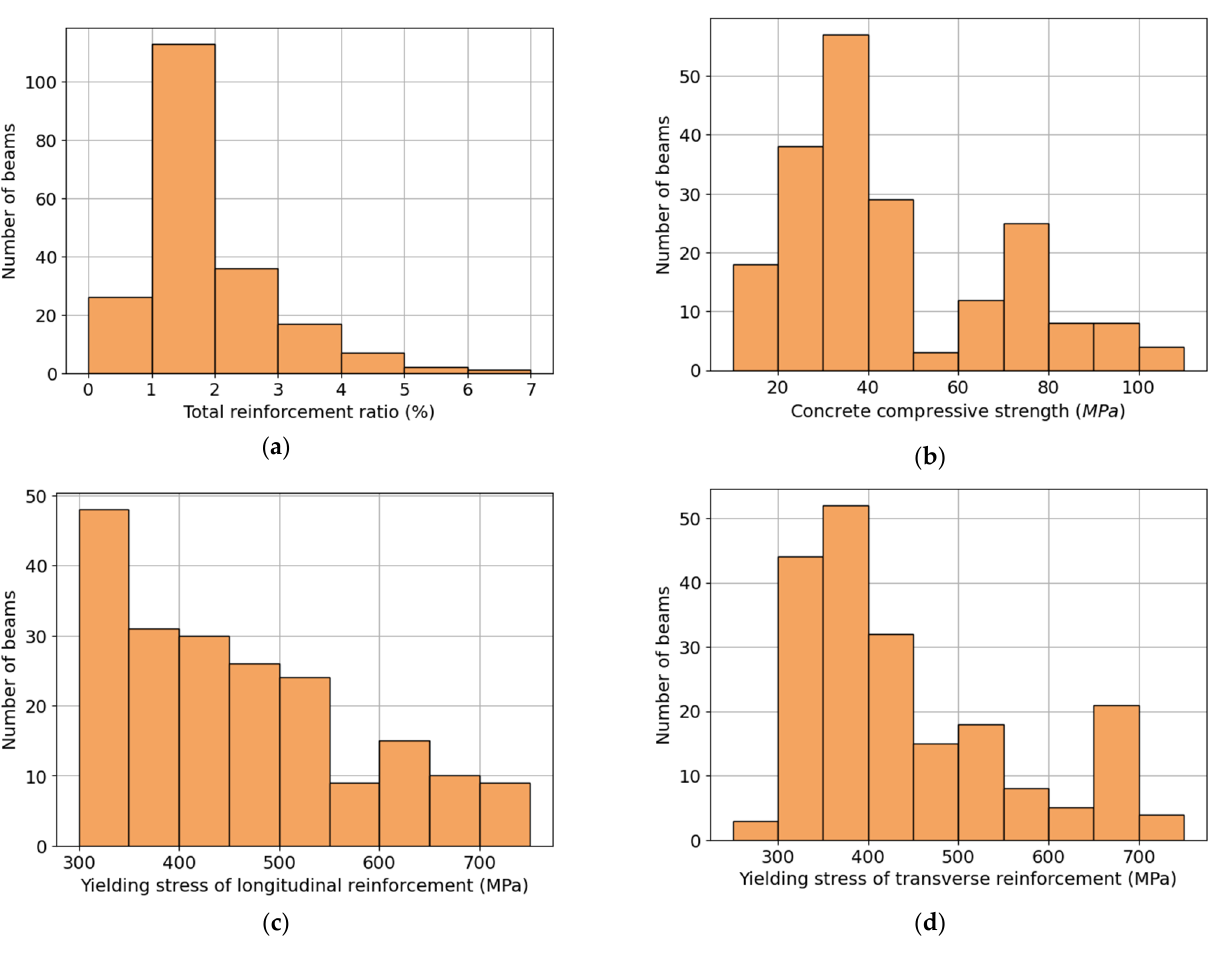
Figure 2. Histograms of key parameters for the RC beams: ( a ) total reinforcement ratio, ( b ) concrete compressive strength, ( c ) yielding stress of longitudinal reinforcement, ( d ) yielding stress of transverse reinforcement.